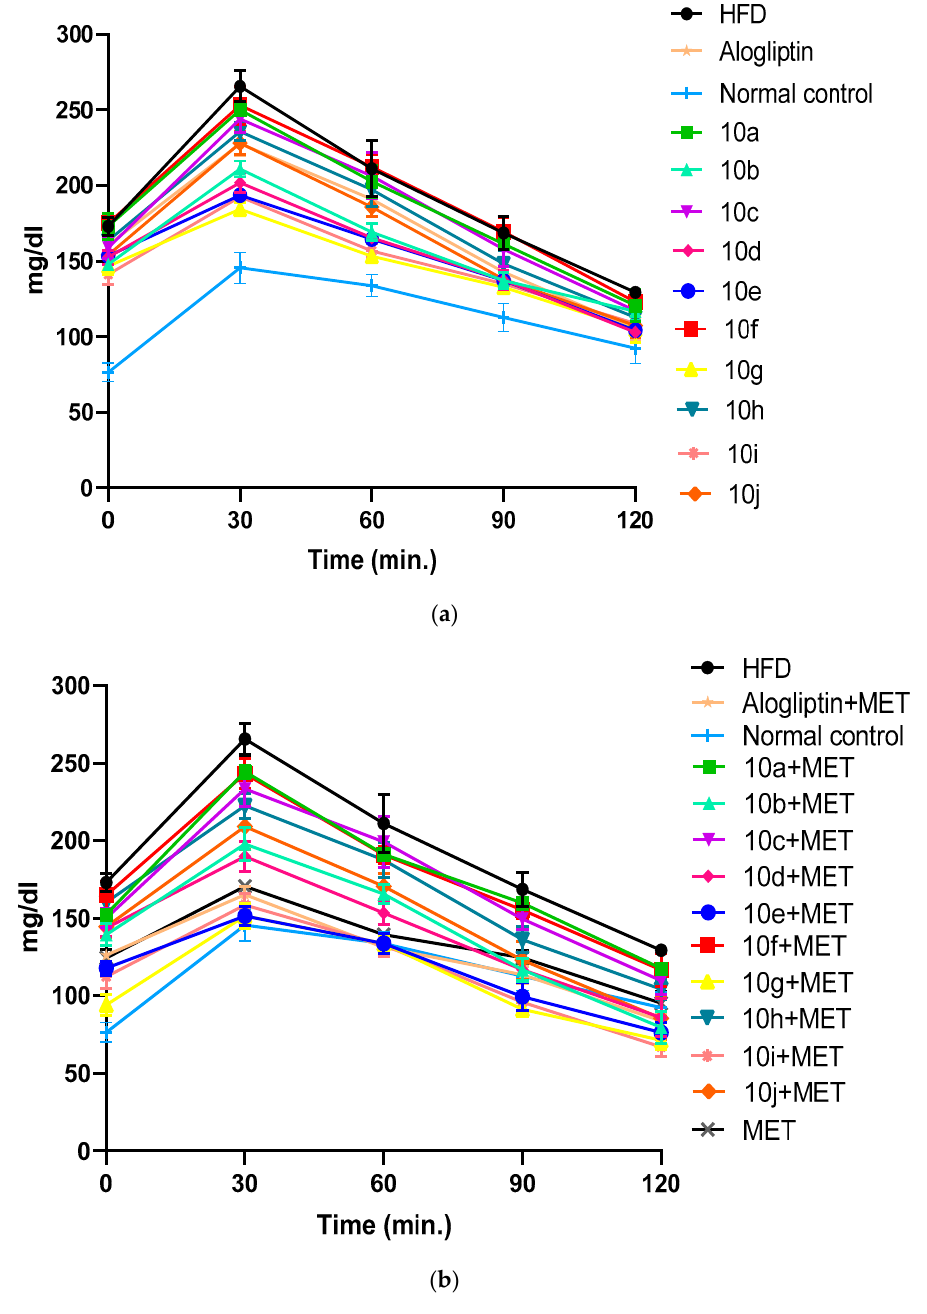
Figure 4. ( a ) Chronic effect of hybrids 10a–j and alogliptin administration on blood glucose levels during an OGTT in type 2 diabetic rats. Data are presented as mean ± SEM ( n = 7). ( b ) Chronic effect of combined administration of 10a–j /MET, alogliptin/MET on blood glucose levels during an OGTT in type 2 diabetic rats. Data are presented as mean ± SEM ( n =